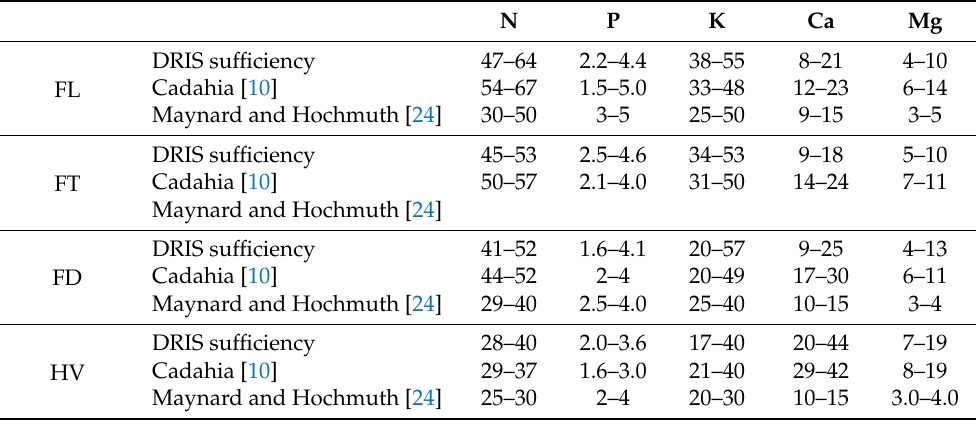
Table 4. Comparative study of DRIS delivered for optimum foliar nutrient concentration ranges